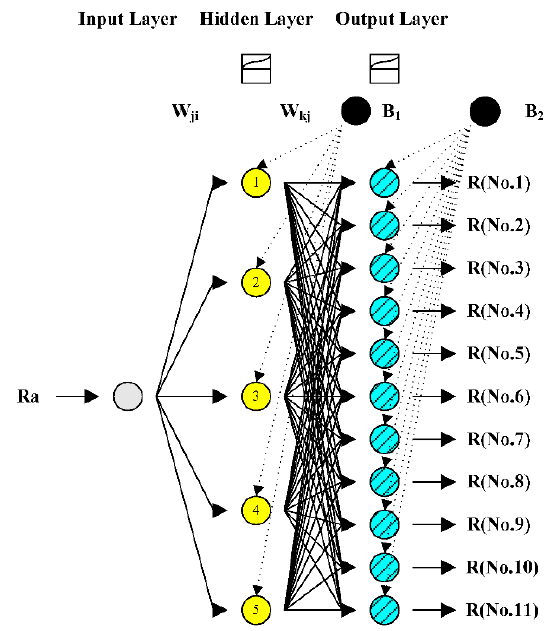
Figure 4. Structure of MLP (1-5-11) developed for spatial disaggregation of areal